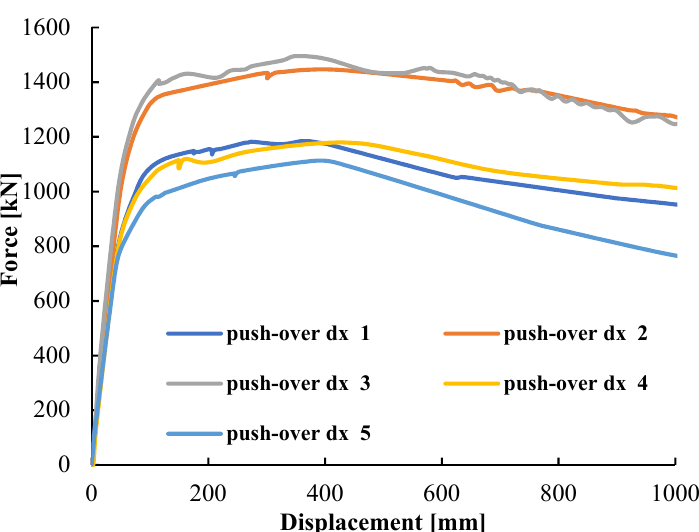
Figure 12. Pushover curves of the 2D frame structure due to different locations of damage.